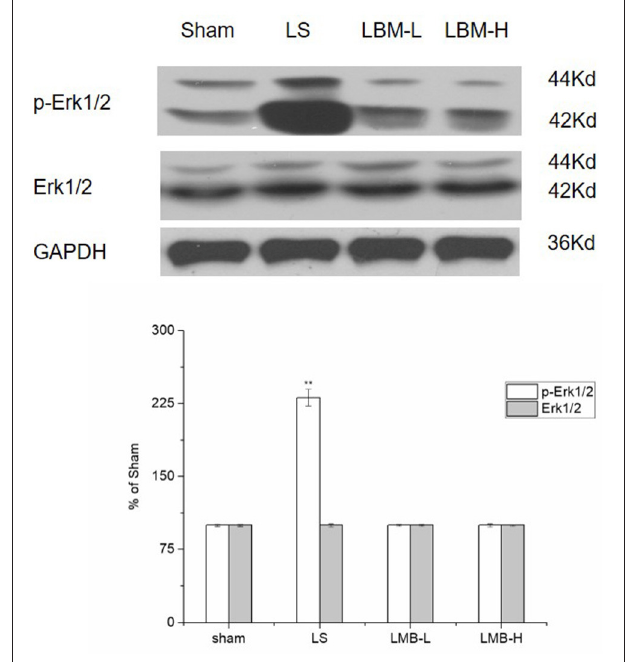
FIGURE 6 | Changes in expression of phospho-ERK1/2, ERK1/2 after either intermittent or continuous L-dopa administration in 6-OHDA-lesioned striatum for 21 days. The expression of phospho-ERK1/2 in the LS group significantly increased compared with the sham, LBM-L and LBM-H group ( p < 0.01). In contrast, no difference was found in the expression of phospho-ERK1/2 among the sham, LBM-L and LBM-H group ( p > 0.05). The level of ERK1/2 protein still remained unchanged in all groups ( p > 0.05). All above protein levels expressed relative to GAPDH levels. The data are expressed in terms of means ± SD and expressed as a percentage of the sham group. ** p < 0.01 vs. sham group ( n = 5 per